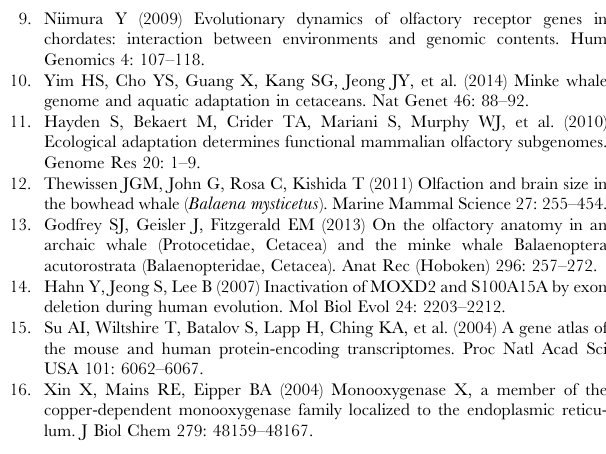
Figure S2 Sequence comparison of the chimpanzee ( Pan troglodytes ) and the northern white-cheeked gibbon ( Nomascus leucogenys ) MOXD2 gene loci. (A) Dot plot comparison of the chimpanzee (horizontal) and the northern white-cheeked gibbon (vertical) MOXD2 loci. In the northern white-cheeked gibbon, the MOXD2 genomic region was replaced with a translocated DNA segment (red box). The chimpanzee MOXD2 and PRSS58 genes are marked at the top with coding and non-coding regions (introns and untranslated regions) in green and yellow, respectively. A dotted horizontal line indicates a gap in the northern white-cheeked gibbon genome assembly ‘‘nomLeu3’’.